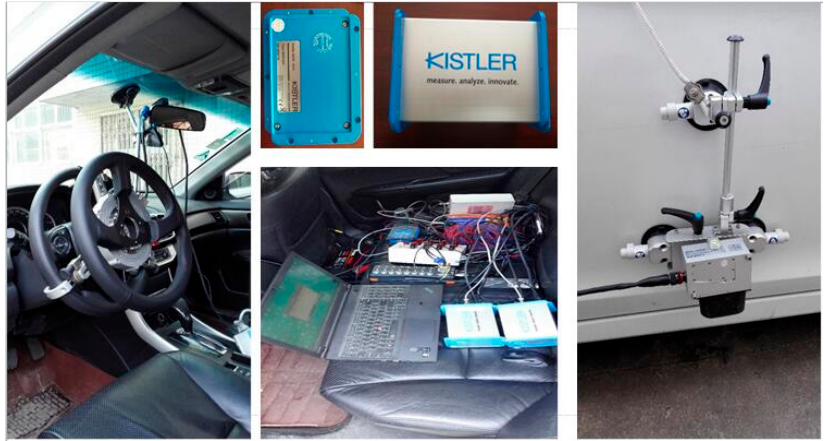
Figure 1. Experimental devices and the actual installation.